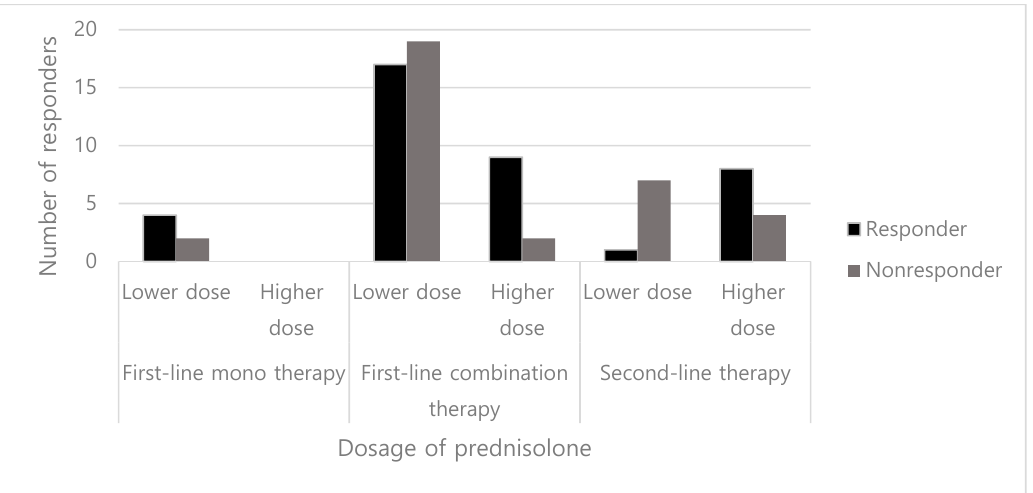
Figure 2. Number of responders by dosage of prednisolone.